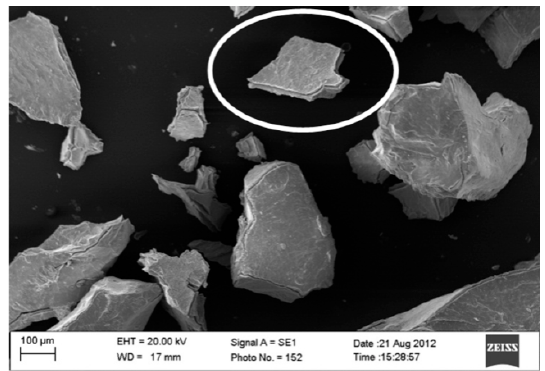
Figure 2. Scanning electron microscopy (SEM) image of powder grains of different size are shown. Each of them present the Cu 10 Zr 7 compound, showing the characterizing micrometric oxide layer.